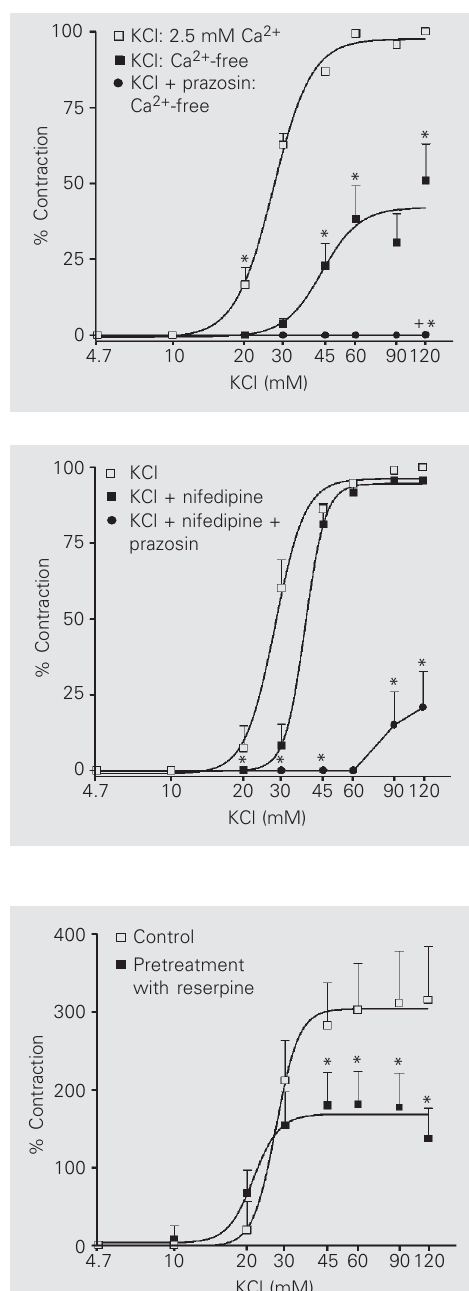
Figure 2. Effect of prazosin on the contractile responses in- duced by KCl in Ca 2+ -free solu- tion. Concentration-effect curves for KCl were constructed in 2.5 mM Ca 2+ Krebs solution (con- trol), and in Ca 2+ -free solution before or after incubation with 1 µM prazosin for 20 min. Data are reported as means ± SEM (N = 7). *P<0.05 compared to con-